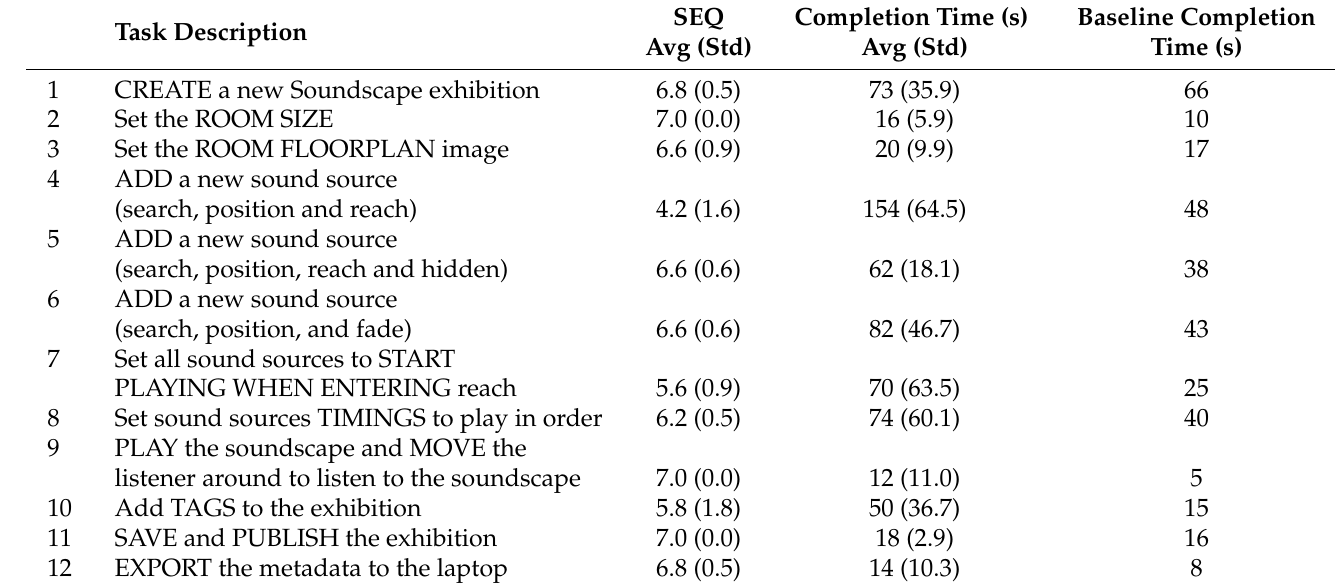
Table 1. Evaluation: Part 1—Single Ease Questions scores and completion times (average and standard